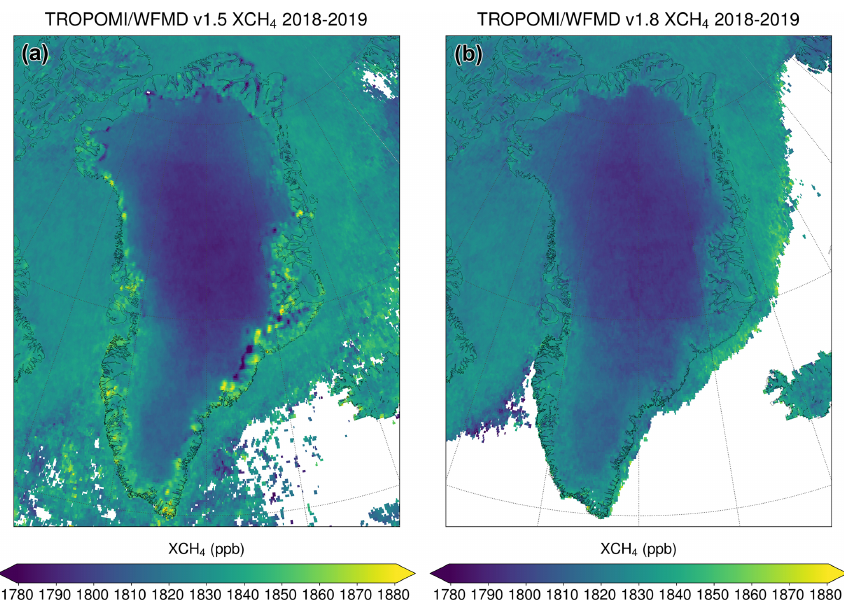
Figure 7. Comparison of the XCH 4 distribution over Greenland for (a) v1.5 based on GMTED2010 and (b) v1.8 using updated topography. The suspicious features, which are correlated with the topography-related differences shown in Fig. 6, disappear when using the GLO-90 digital elevation model. The differences in coverage over the ocean are due to the stricter quality filter in v1.8 (see Sect.